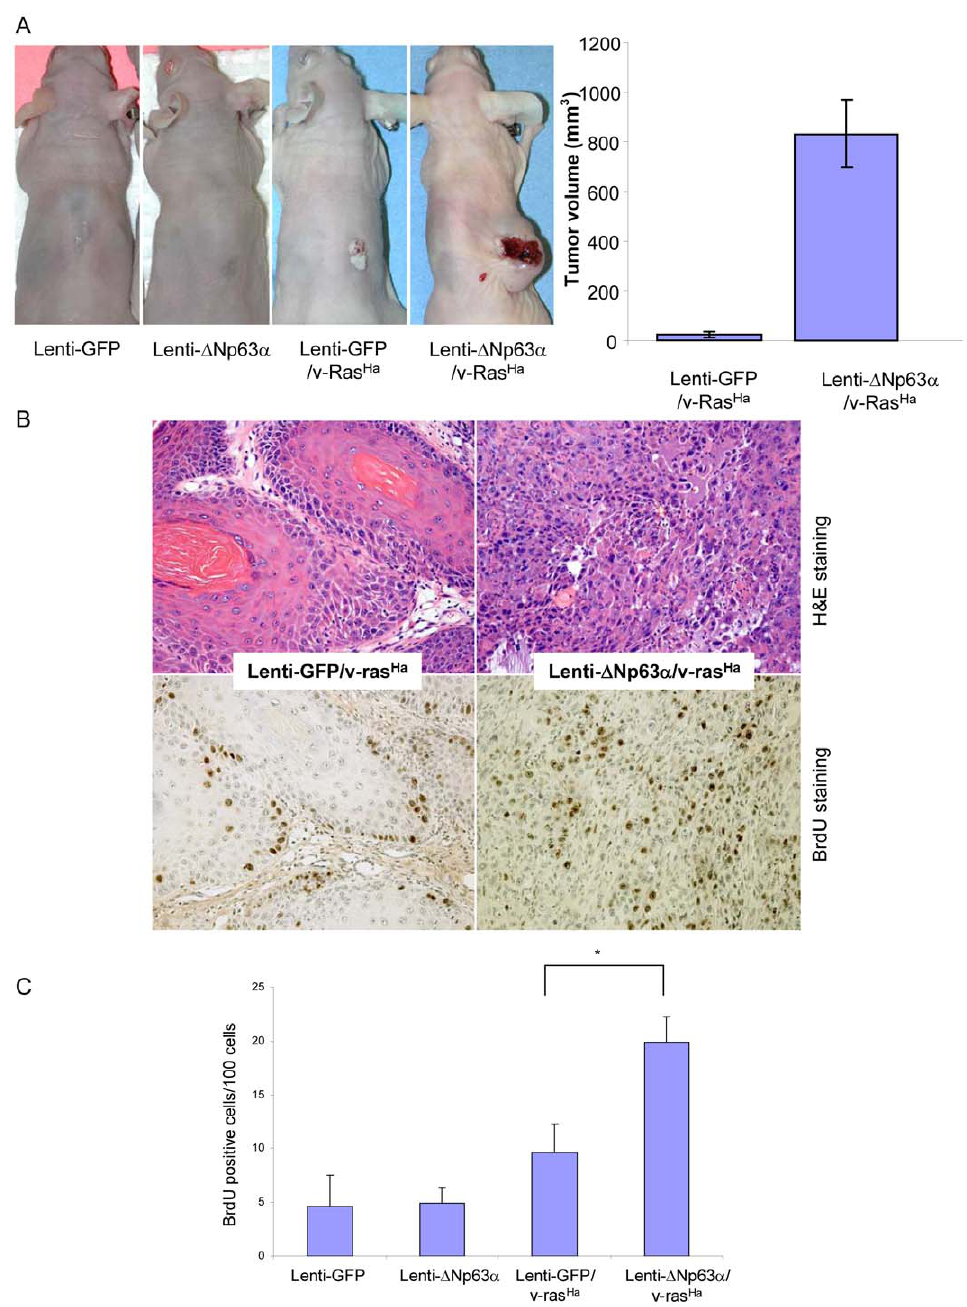
Figure 4. Elevated expression of D Np63 a enhances malignant conversion in v-ras Ha -expressing keratinocytes. A, In vivo phenotype of D Np63 a -overexpressing keratinocytes in the presence and absence of oncogenic ras. Primary mouse keratinocytes were infected with lentivirus encoding lenti-GFP or lenti- D Np63 a or sequentially with retrovirus encoding v-ras Ha followed by lenti-GFP or lenti- D Np63 a . The final tumor phenotype was assessed at 5 weeks following grafting. Final tumor volumes at 4 weeks are presented as the mean tumor volume 6 S.E. B, Upper panel, representative H&E sections of tumor tissues obtained from grafting sites. Lower panel, BrdU incorporation in grafted tissue samples. C, Quantification of BrdU incorporation levels. Data are presented as the mean % of BrdU positive cells 6 S.E. * indicates a statistically significant difference between lenti-GFP/v-ras Ha and lenti- D Np63 a /v-ras Ha groups at p , 0.05.